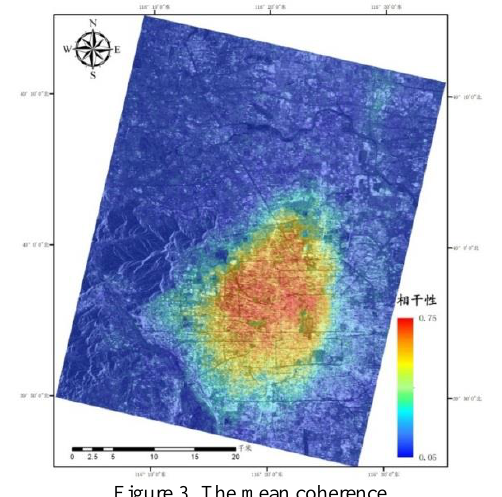
Figure 3. The mean coherence Making Differential interference processing and filtering processing to the interferograms pairs. Then unwrapping the interferometric phase by the method of Minimum Cost Flow which based on the Delaunay triangulation network and generated 67 phase unwrapping pictures (Figure